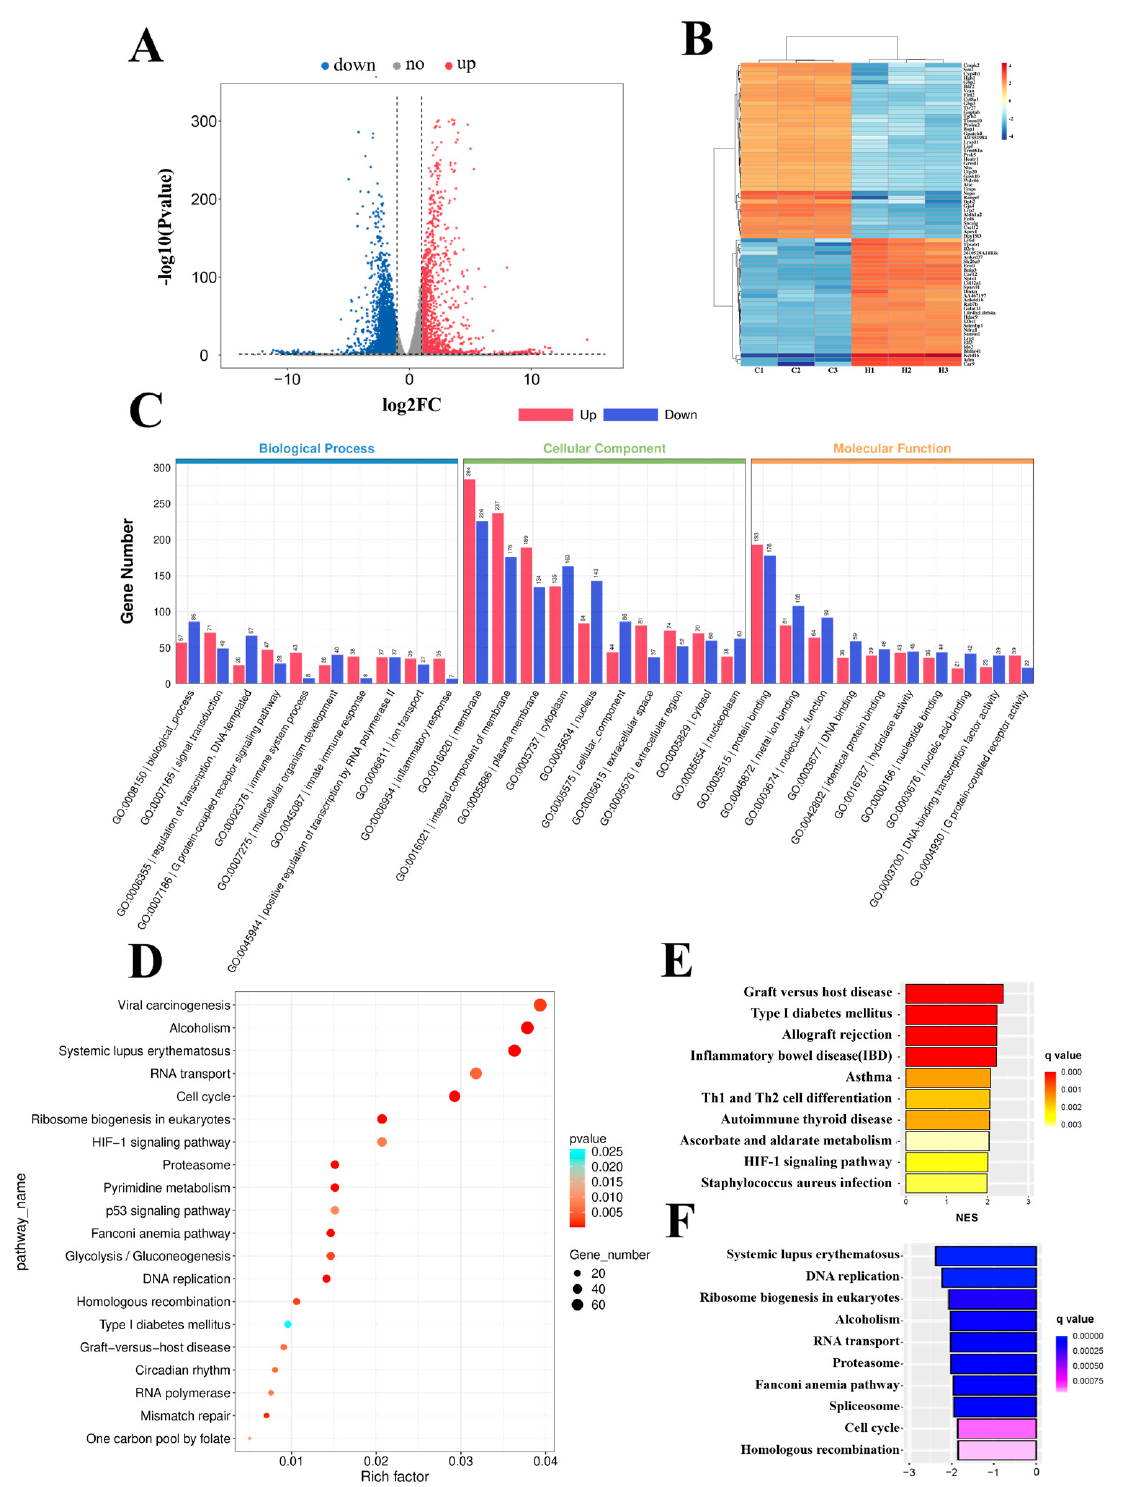
Figure 1. Functional analysis of differentially expressed genes (DEGs) in bEnd.3 cells under 24 h hypoxia. ( A ) Volcano map of differentially expressed genes between the control and hypoxia conditions. ( B ) Heatmap of the top upregulated and downregulated genes. ( C ) Gene ontology (GO) term analysis of differentially expressed genes. ( D ) Top 20 Kyoto Encyclopedia of Genes and Genomes (KEGG) pathways. ( E ) Top 10 upregulated pathways from gene set enrichment analysis (GSEA). ( F ) Top 10 downregulated pathways from